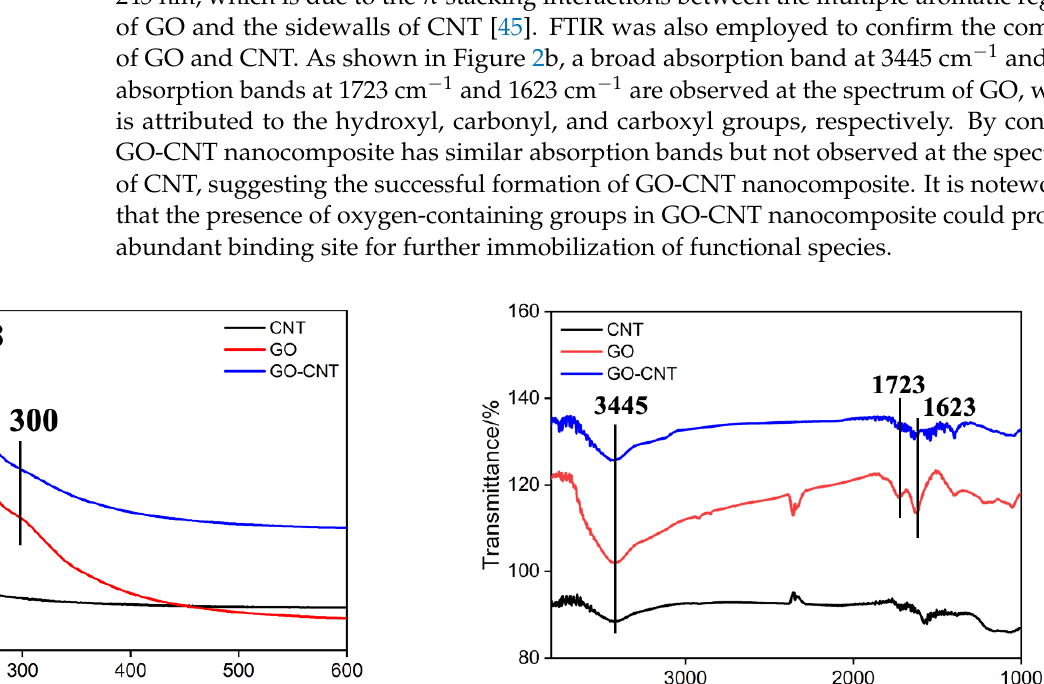
( c ) Figure 3. ( a ) CV curves of the bare ITO electrode in 0.2 M PBS (pH = 6.5) containing GO-CNT. Inset is the corresponding 30-successive CV curves. High-resolution C 1 s XPS spectra of ( b ) GO- CNT/ITO, ( c ) ErGO-CNT/ITO electrode.